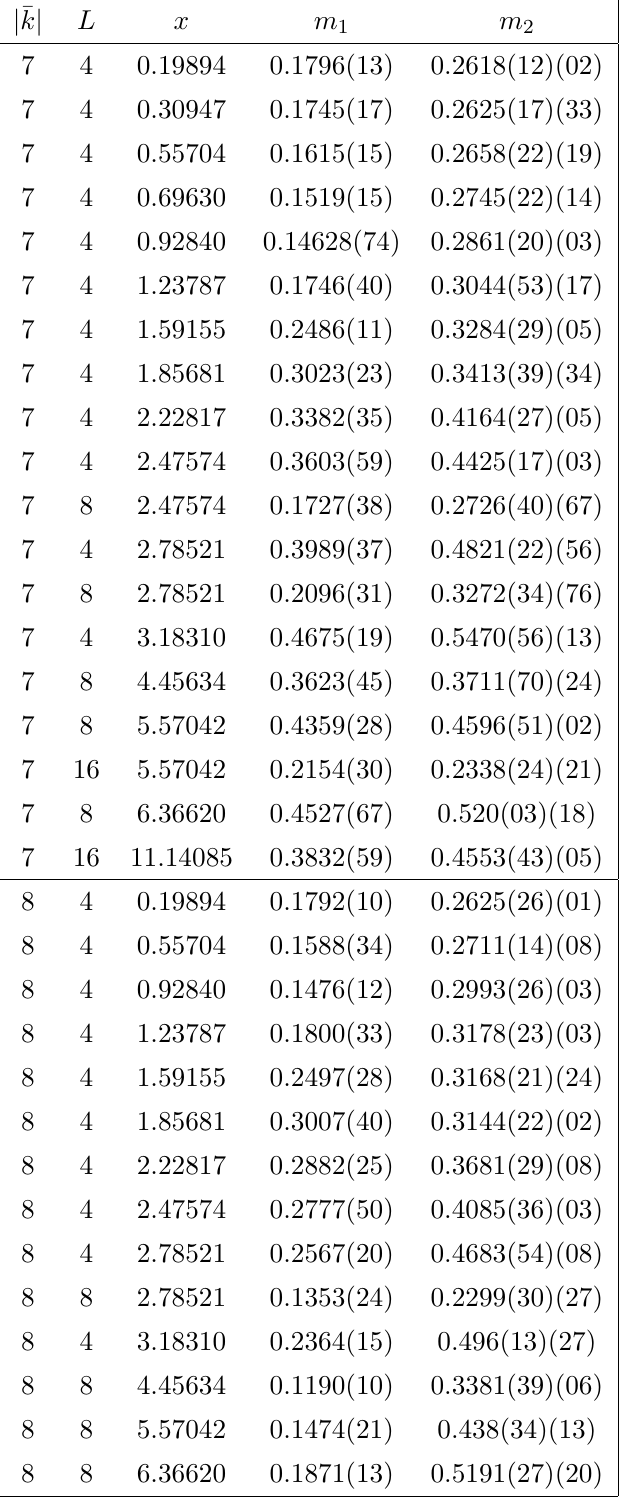
Table 28. Mass gap and next excited state energy (in lattice units) in the zero-electric (cid:13)ux scalar sector for SU(17)